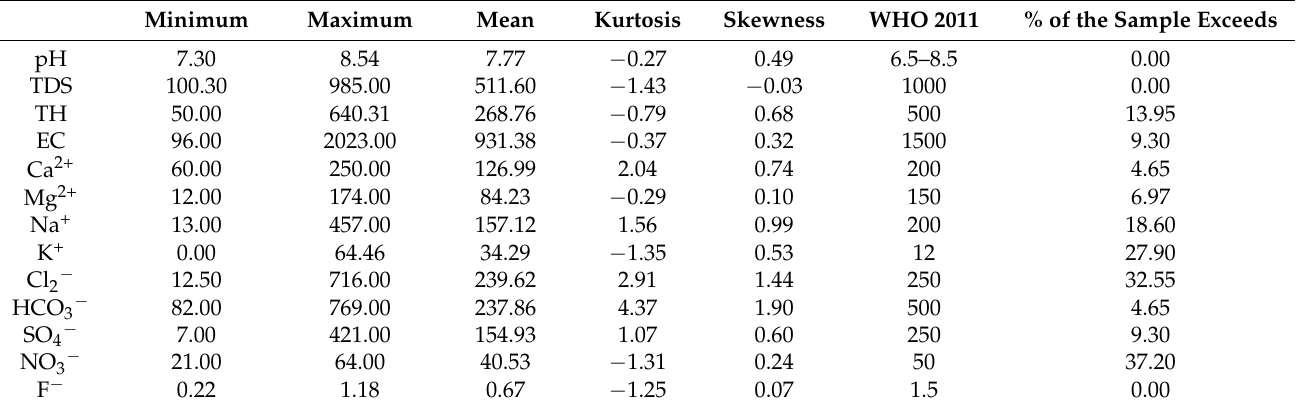
Table 1. Statistical analysis of groundwater samples in study